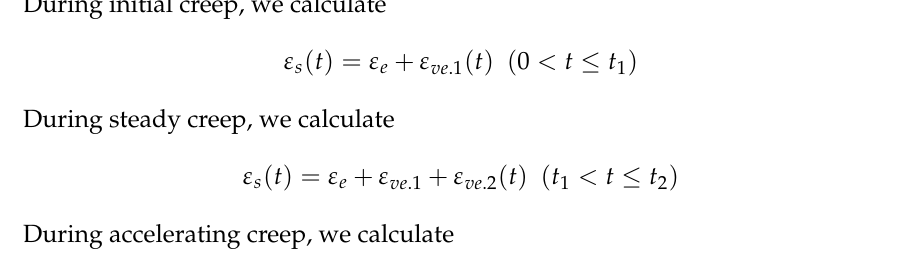
Figure 3. Representative creep strain-time curve of clay.